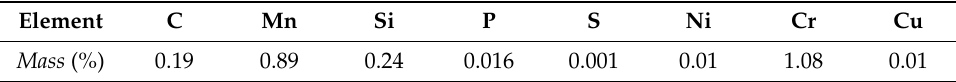
Table 2. The process parameters and physical properties of steel.